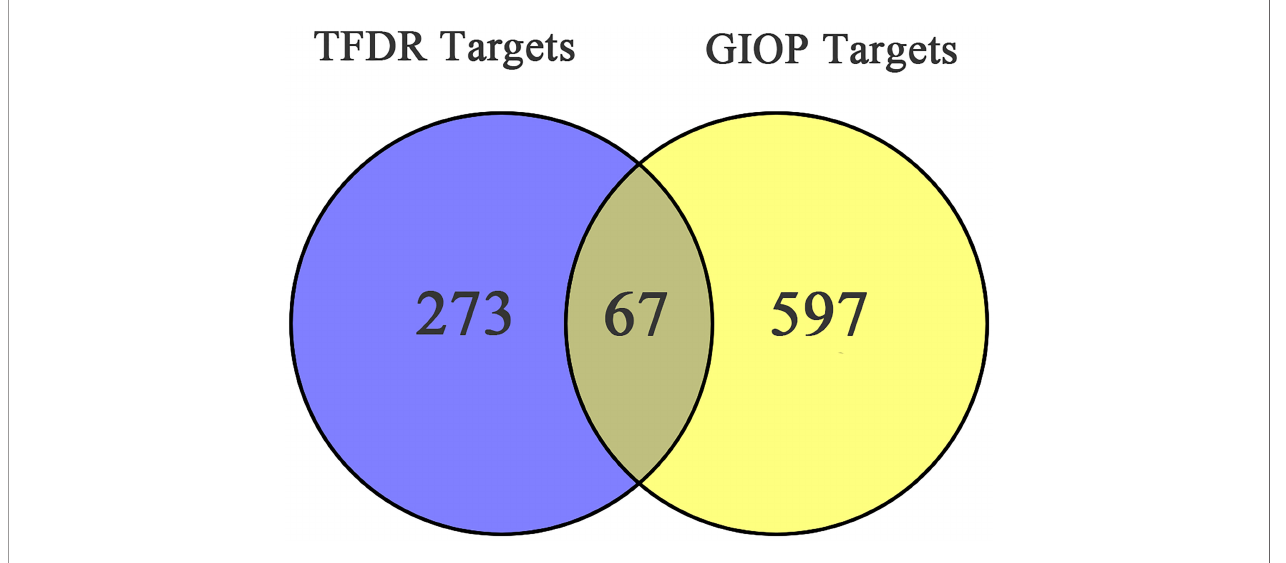
FIGURE 2 | The Venn diagram of targets in TFDR and